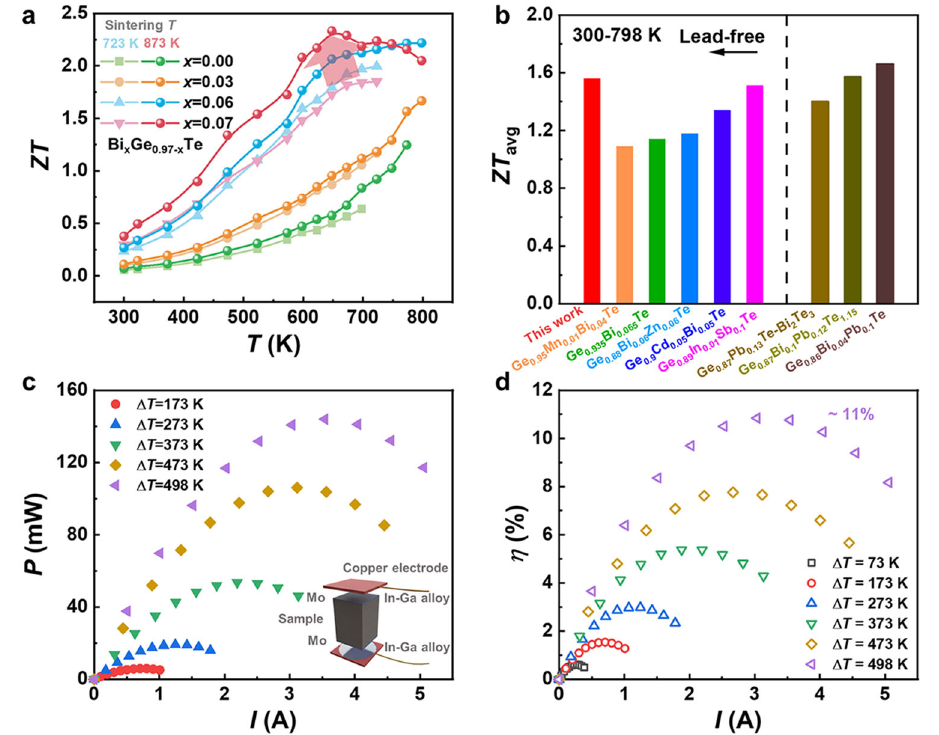
Fig. 5 | Thermoelectric properties and conversion ef fi ciency. Temperature- dependent a fi gureofmerit ZT forBi x Ge 0.97 – x Te-723andBi x Ge 0.97 – x Te-873samples and b the average ZT for the Bi 0.07 Ge 0.90 Te-873 sample compared with the